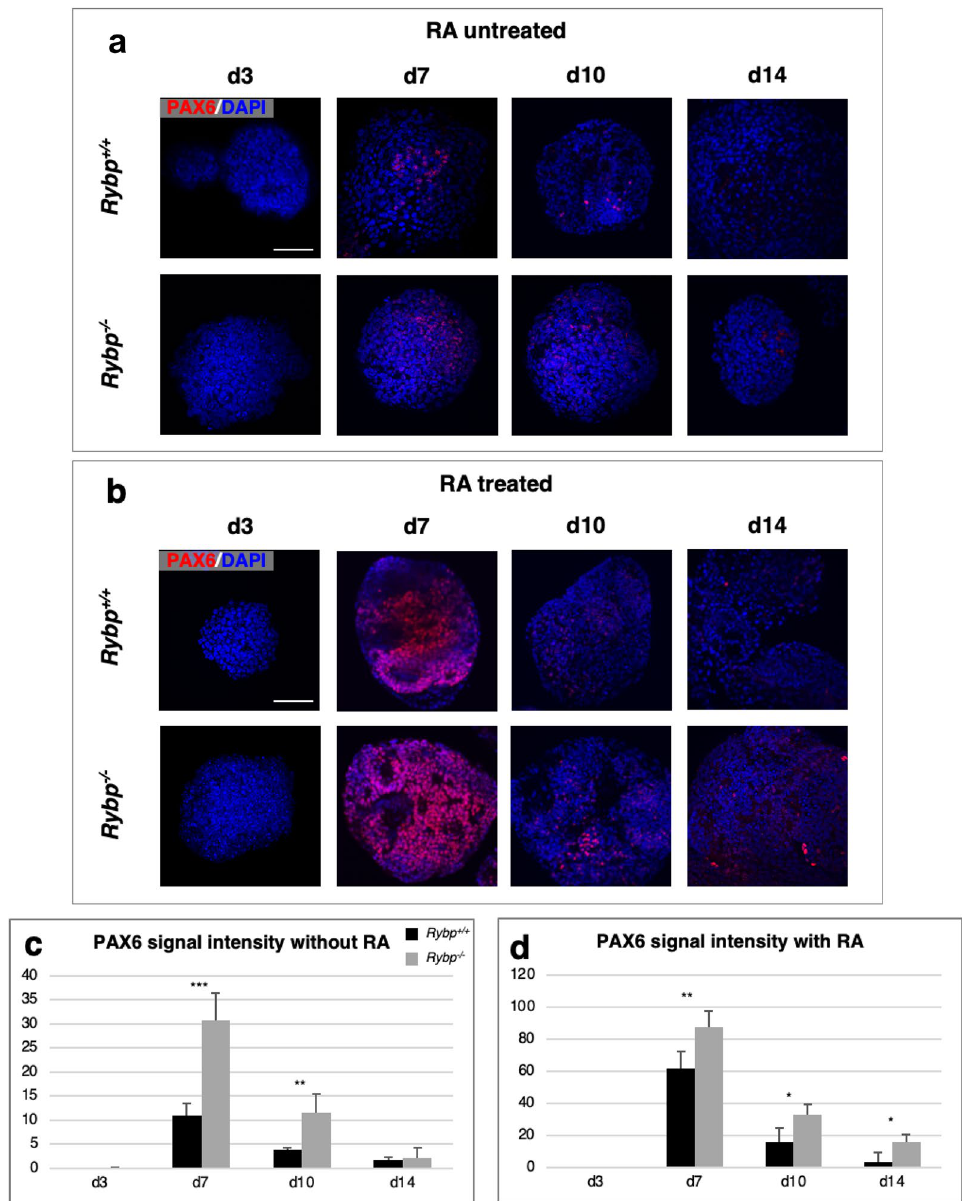
Figure 3. PAX6 is strongly upregulated in the lack of Rybp ( Rybp −/− ) during neural differentiation of ES cells. Immunocytochemical analysis of PAX6 protein level in EBs in the ( a ) absence and ( b ) presence of atRA revealed increased PAX6 signals in the Rybp −/− cells compared to the wild type cells. Objective: 40 × . Scale bar: 80 μm. ( c , d ) ImageJ quantification of PAX6 protein level in the wild type and Rybp −/− cells during the in vitro neural differentiation in the absence ( c ) and presence ( d ) of atRA. Means are standard deviation ± SD. Values of p < 0.05 were accepted as significant (* p < 0.05; ** p < 0.01; *** p < 0.001). Statistical method: t test type 3, n =